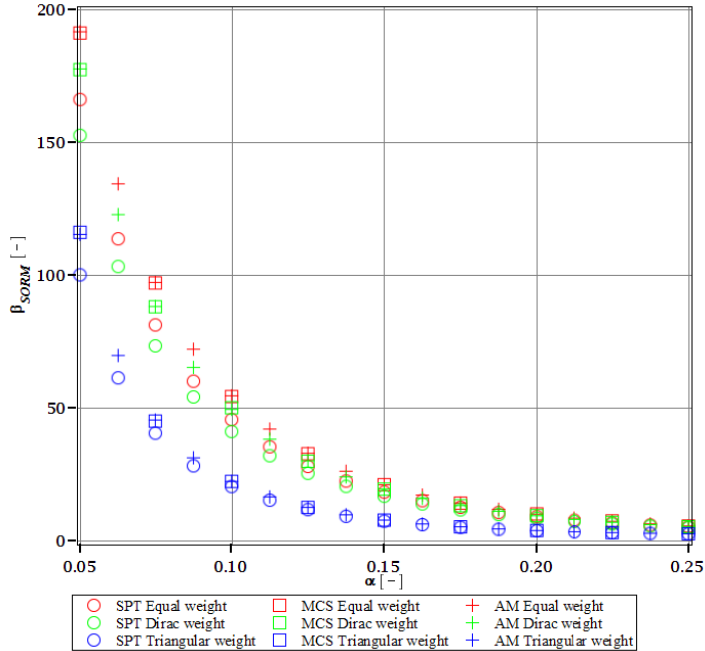
Figure 14. Reliability index of the corrugated I-beam for different types of weights according to the second-order reliability method (SORM) — shear.